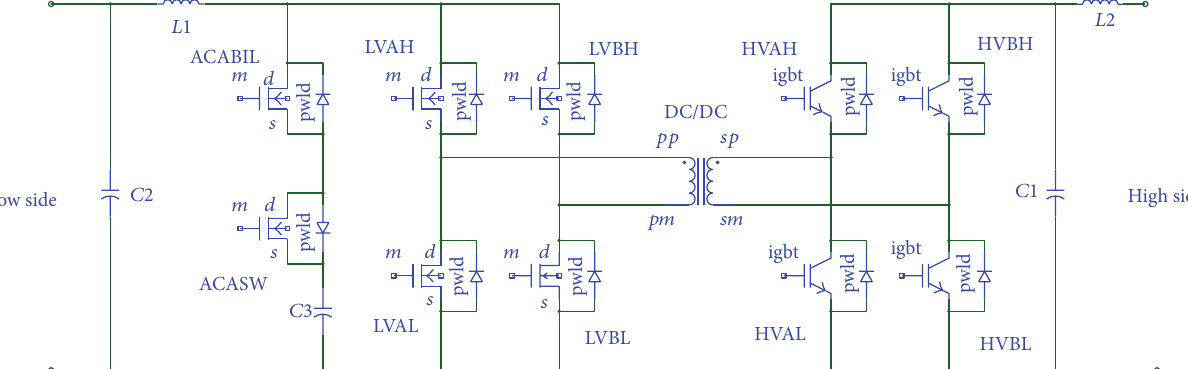
Figure 2: Boost full bridge with active clamp